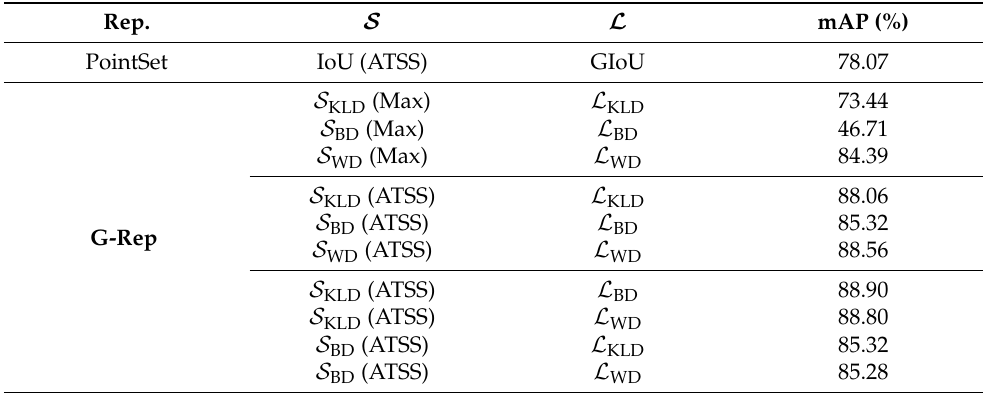
Table 4. Comparison of the three Gaussian distances as metrics for label assignment and regression loss on HRSC2016. Rep.